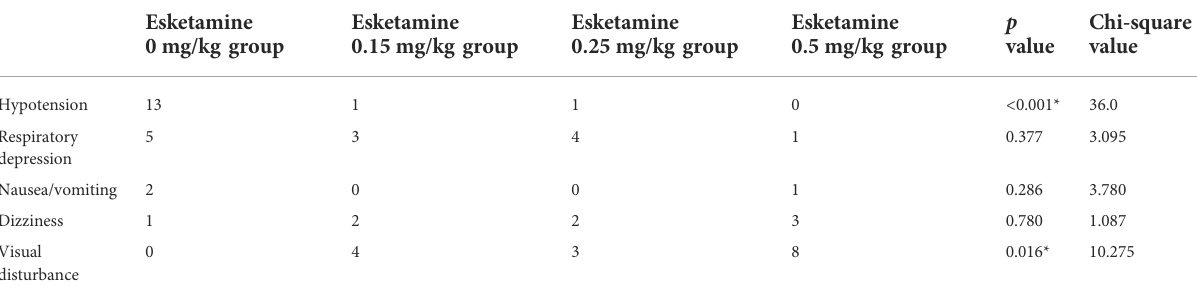
TABLE 4 Adverse